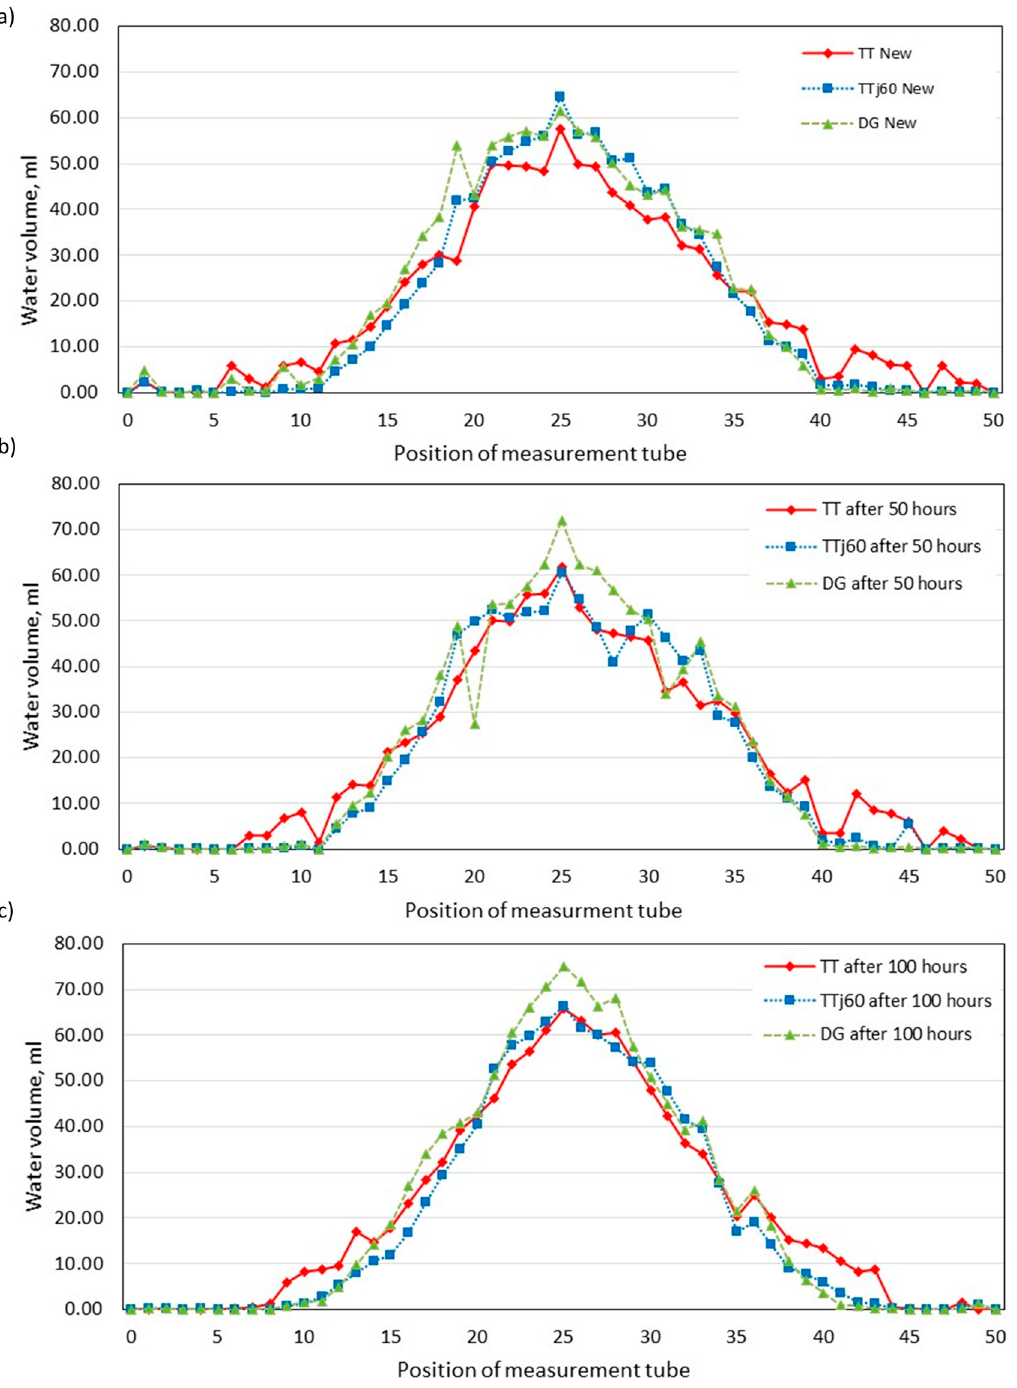
Figure 7. Spray distribution of the TT, TTj60, and DG nozzles before the wear test: ( a ) new nozzles, ( b ) after 50 h, ( c ) after 100 h.